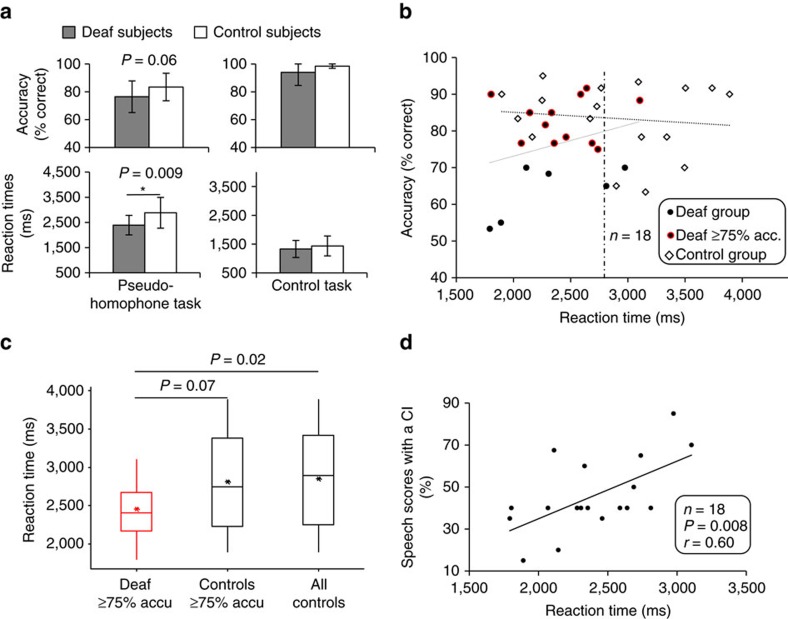
Behavioural results.(a) Mean performance and reaction times (% correct and RTs in milliseconds ms±s.d.) during phonological (rhyming decision on pseudo-homophones) and control (orthography decision) tasks in post-lingual deaf and normal-hearing control subjects. * Significant difference at P<0.05. (b) Phonological performance (% correct) as a function of RT (ms) in deaf (black dots with and without red-circle) and control (open diamonds) subjects. There was no statistical correlation between RT and performance in either group (the grey dotted lines represent theoretical linear regression lines). The deaf subjects who performed ≥75% correct are circled in red. The controls' mean and median RT is represented by a vertical dotted line (similar number: 2,728 and 2,757 ms, respectively). (c) Box plots of RTs in those deaf subjects who performed ≥75% correct (in red) and controls (good performers ≥75% and whole group). These good deaf performers had significantly faster RTs than the control group. Horizontal bars represent the medians and asterisks the means. (d) Post-cochlear implant (CI) scores (speech comprehension, % correctly repeated words) in post-lingual deaf subjects as a function of RT during the phonological task. A statistical correlation shows that the fast responders became poor proficient CI users.